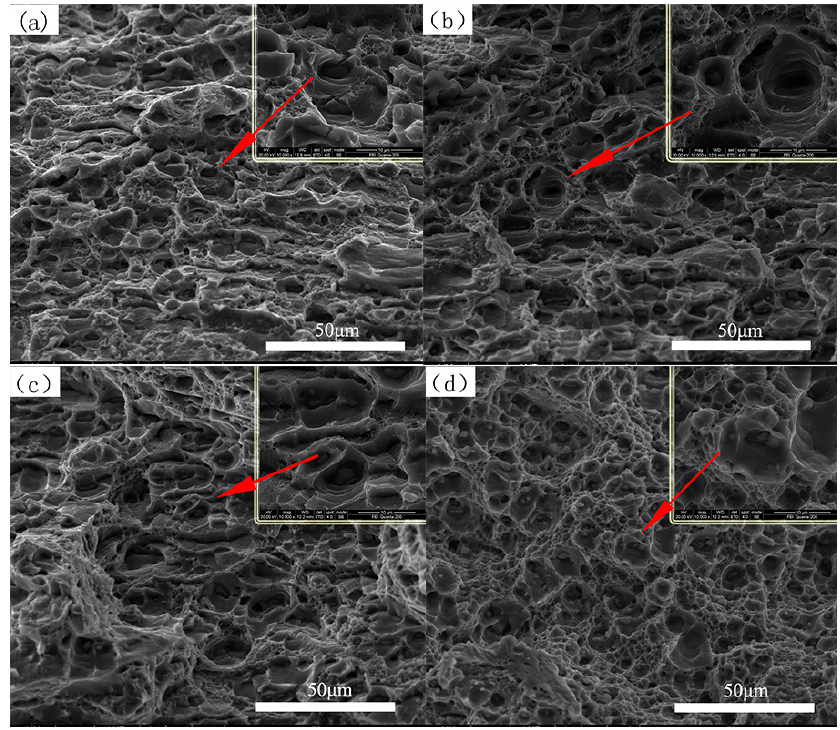
Figure 3. Fracture morphology of AA specimens. ( a ) 4 h/175 °C; ( b ) 8 h/175 °C; ( c ) 14 h/175 °C; ( d ) 24 h/175 °C.